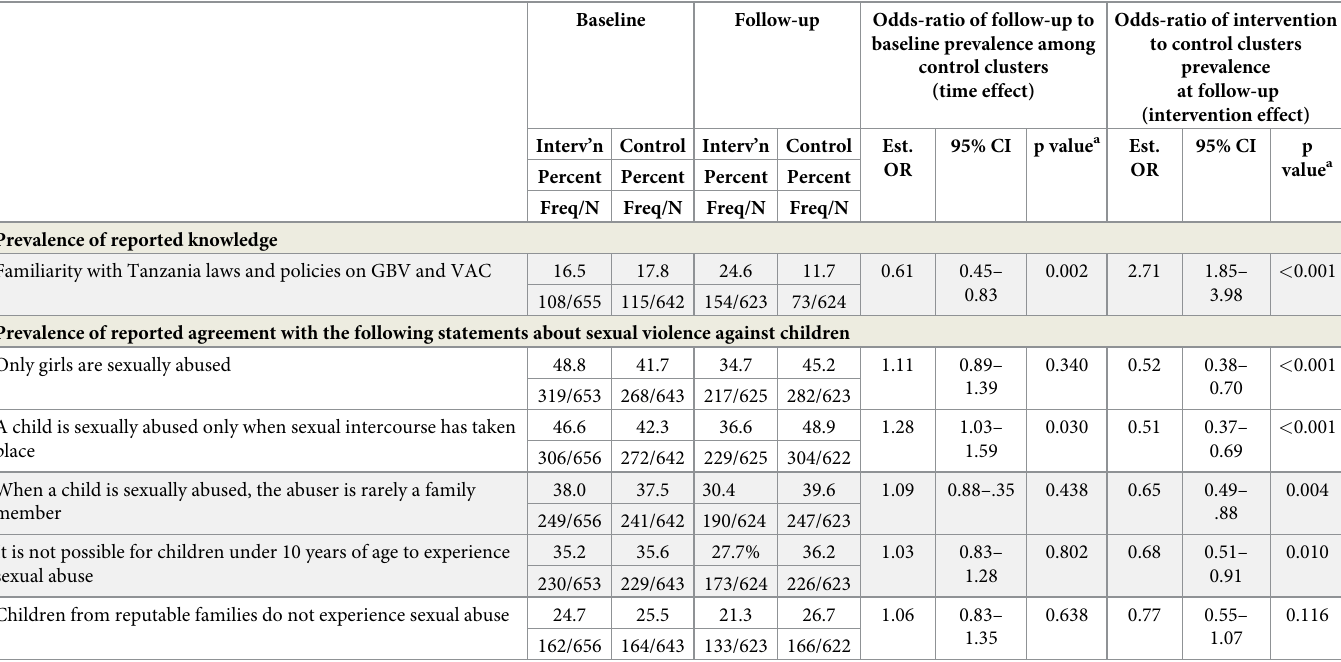
Table 8. Reported knowledge about GBV including sexual violence against